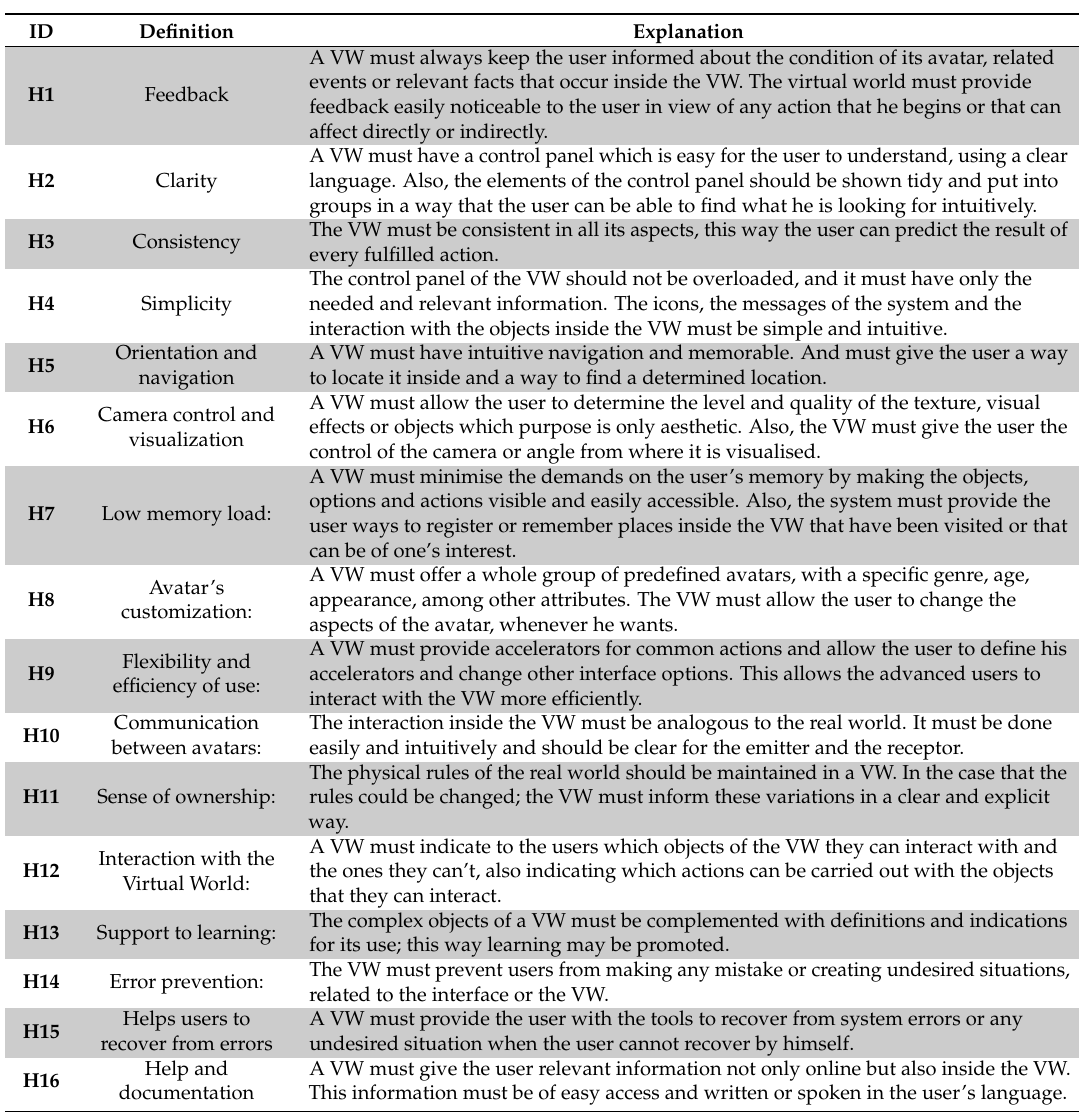
Table 3. The list of 16 heuristics used in the evaluation of the